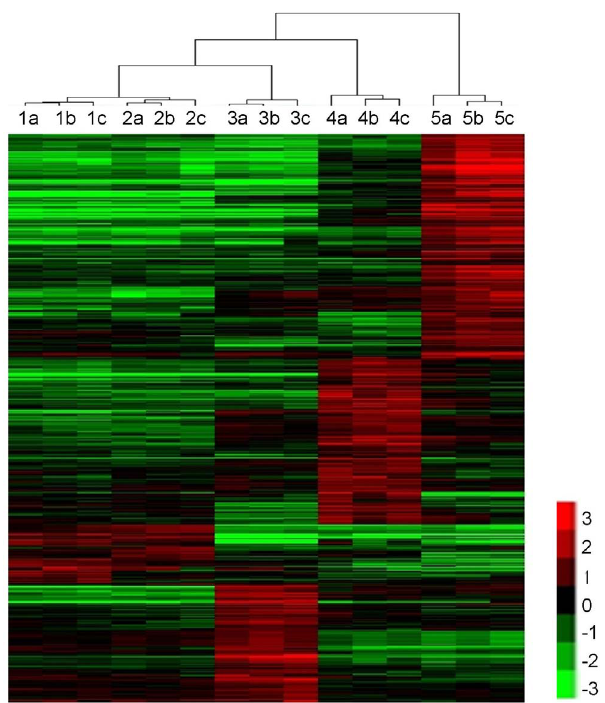
Figure 1. Dendrogram of 548 tissue-specifically expressed genes in five tissues of Sorghumpropinquum . 1. Rhizome tips,